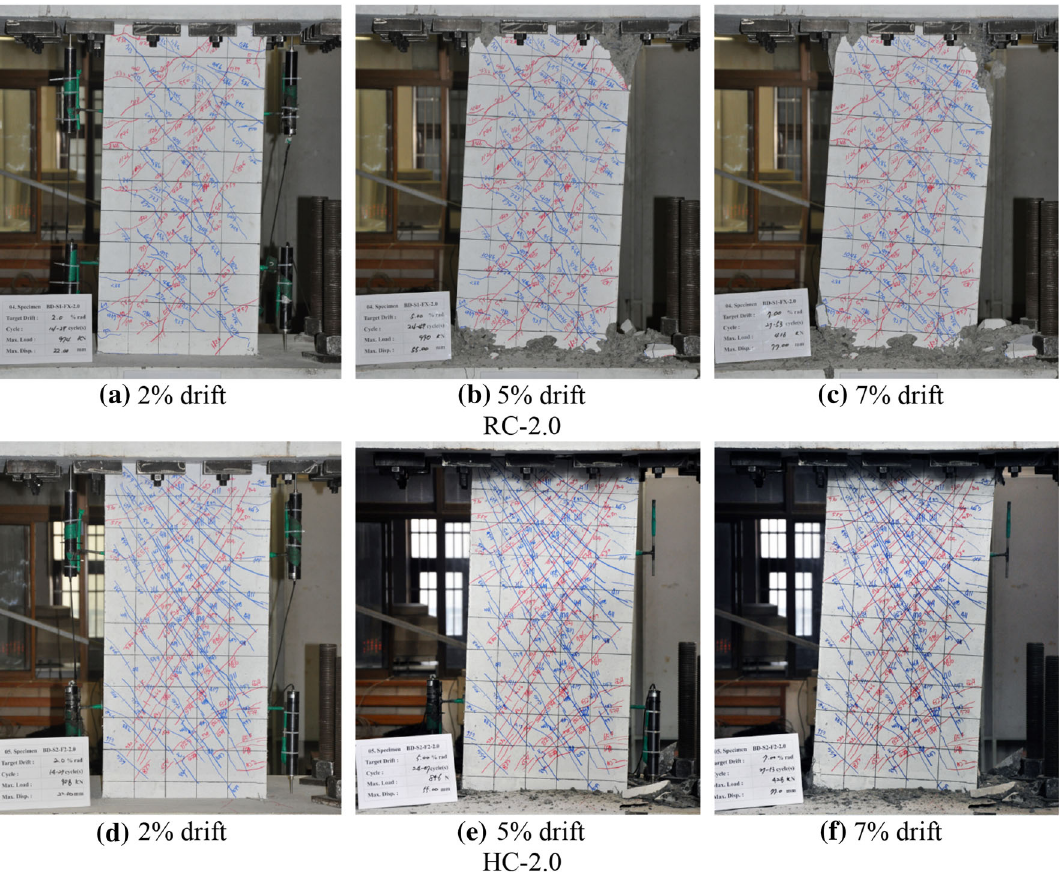
Fig. 8 Crack patterns in two specimens of aspect ratio